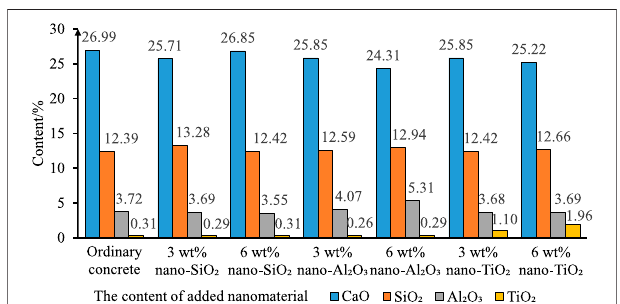
FIGURE2| Mainoxidecontentsindifferentsaturatedconcretesamples.